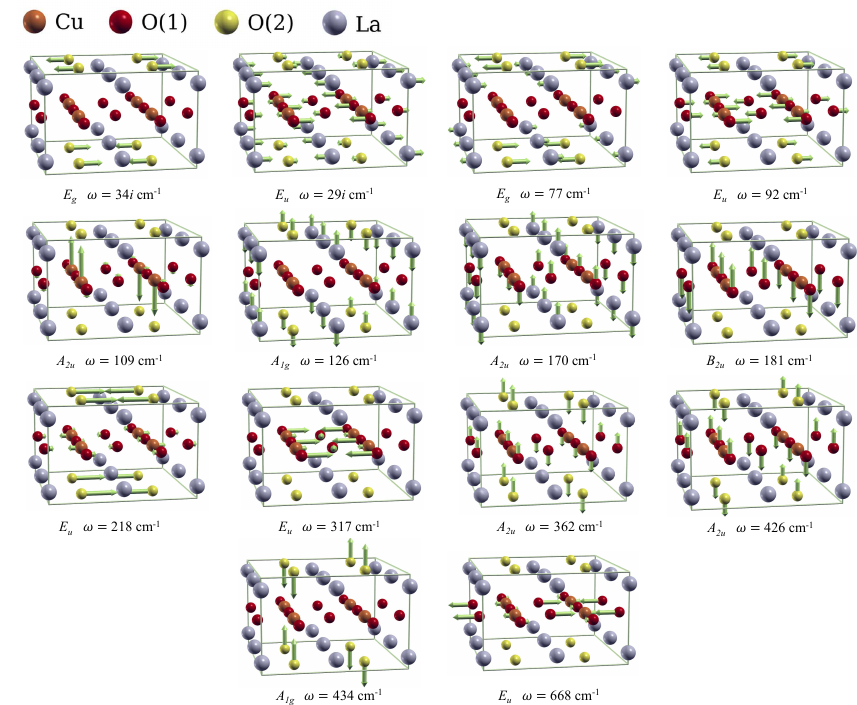
Figure A2: All LCO modes at the X point, represented in a 2x2